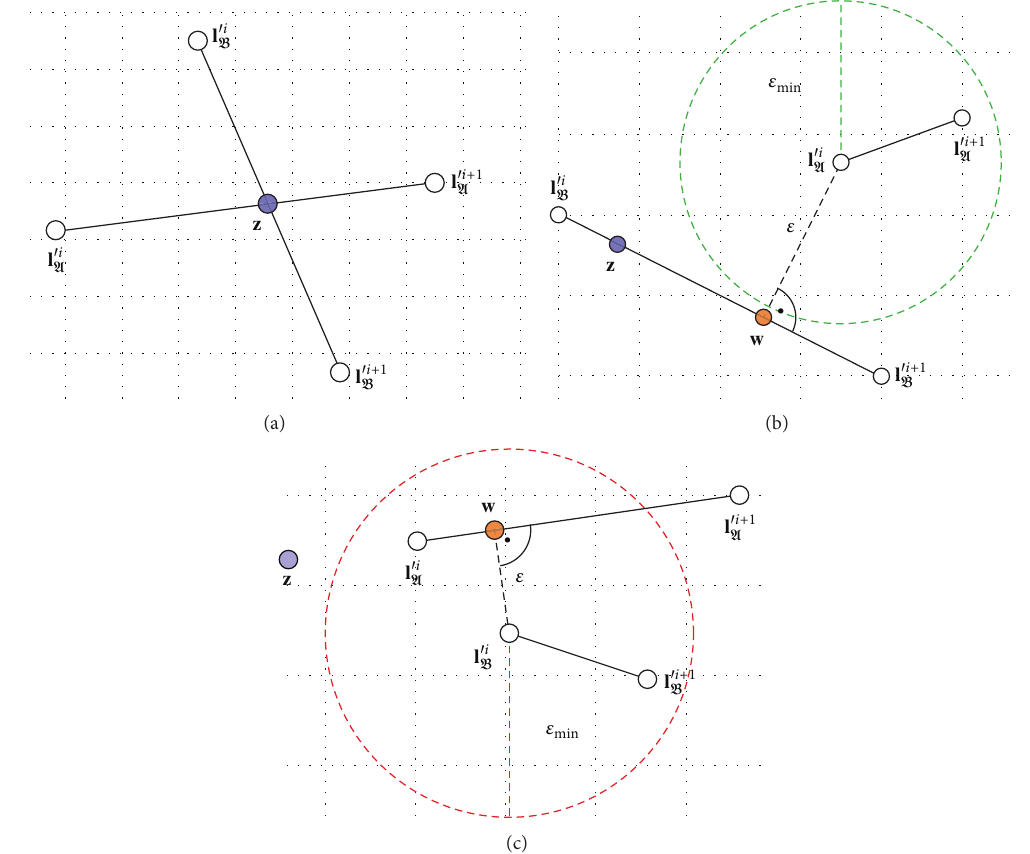
Figure 13: Detecting intersections of two line segments, where the grid has the size 1pt to suggest the synthesized image, 𝜀 is 2 pt. (a) The lines segments intersect. (b) The line segments are close and s B points to s B , but there is no need to move A since their shortest distance 𝜀 is higher than 𝜀 min . (c) The intersection point z is outside both line segments, but 𝜀 is smaller than 𝜀 min , so an intersection of the corresponding lines of the synthesized image is